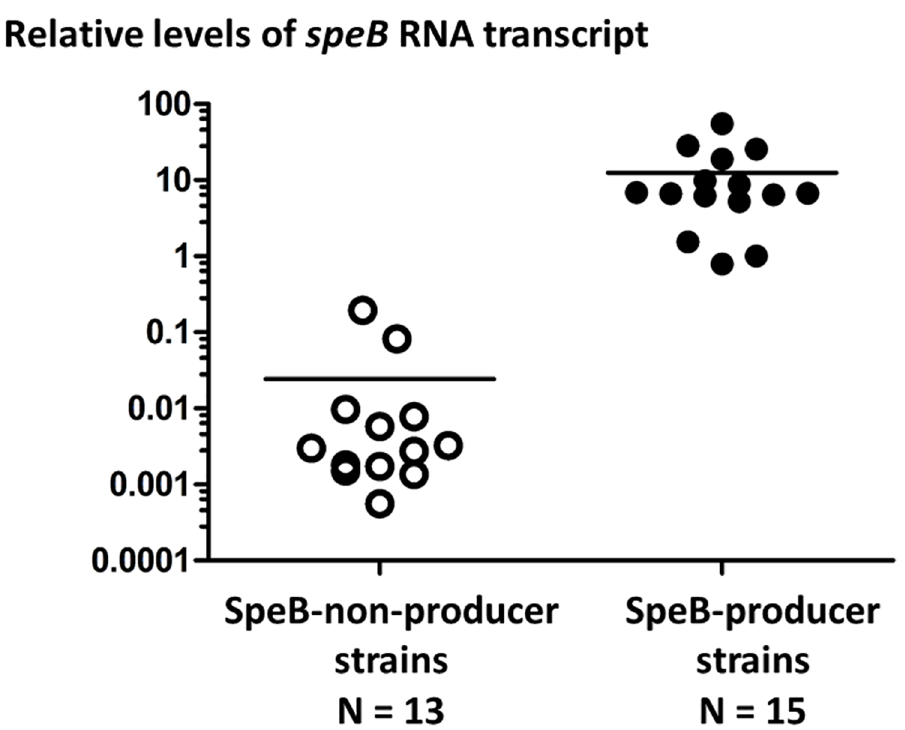
Fig 2. Relative speB RNA transcript levels for SpeB-producer and non-producer GAS strains. Normalized(log 10 ) relative levels of speB transcript for SpeB-producer and non-producer GAS strains are plotted. A single RNA/cDNA sample of the SpeB-producer strain CT02-99( emm6 )was chosen as the reference for normalization;its relative speB transcript level was adjusted to 1. Mean averagevalues for each group are indicated(bars).